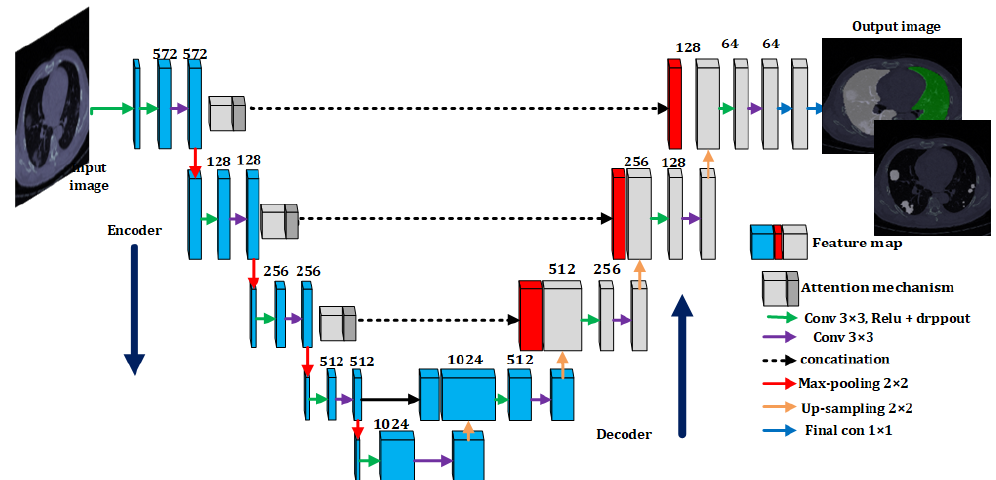
Figure 3. U-Net architecture with attention mechanism utilized for segmentation of lungs and COVID-19 infected